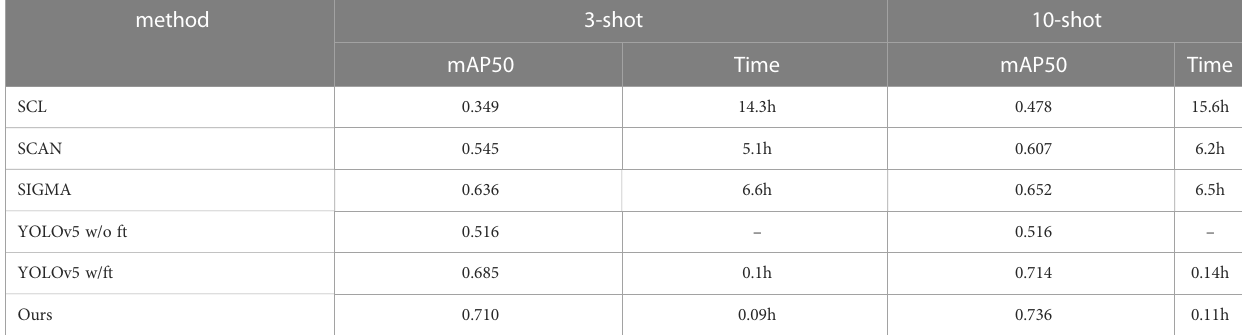
TABLE 2 Our comparison results with other methods on the URPC2022 and Aquarium dataset.